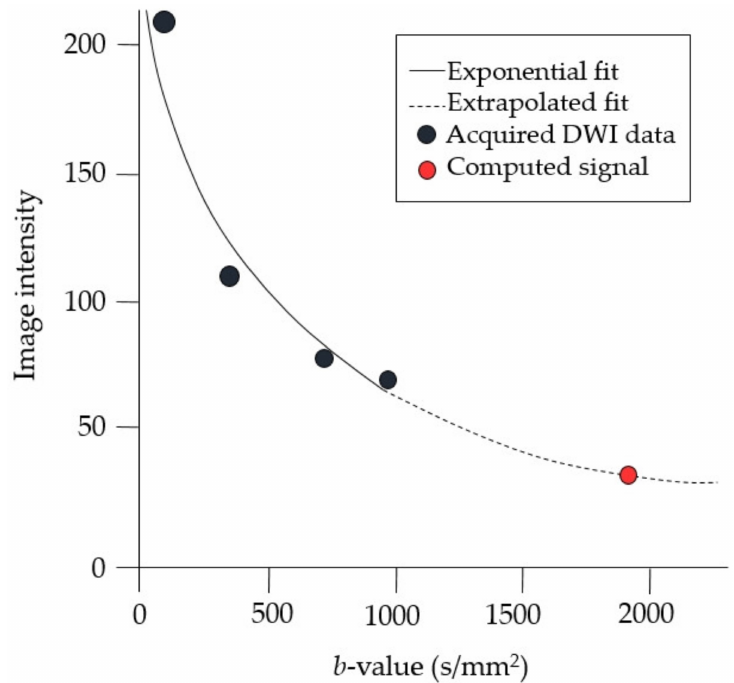
Figure 1. Principles of computed di ff usion-weighted imaging (DWI) technique. The technique is based on the principle of DWI, wherein the values of apparent di ff usion coe ffi cient of various b -values were fit to an exponential